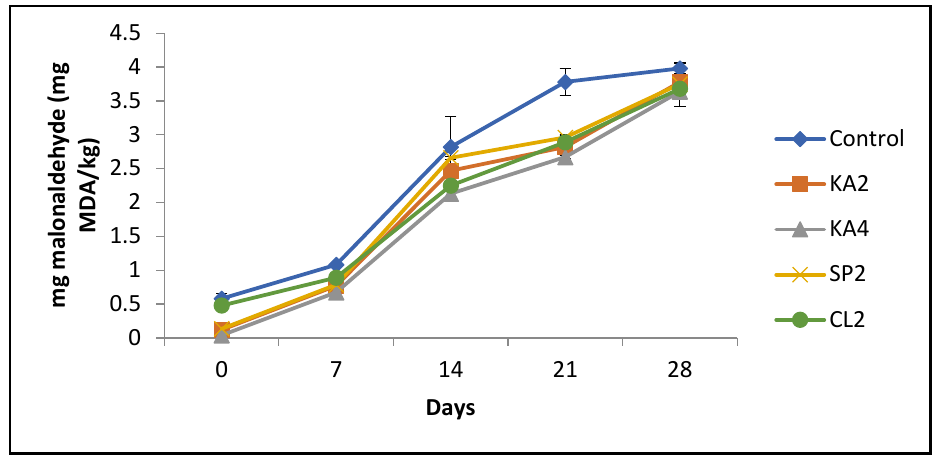
Figure 2. TBARS value of chicken sausage with added seaweed within 30 days of storage at 4 °C temperature.